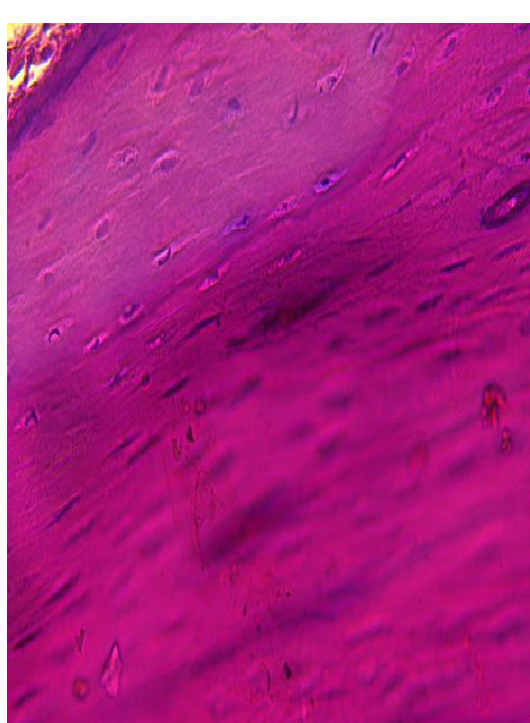
Figure (8 ): Theosteoid formation in collagen treated group after 2 weeks